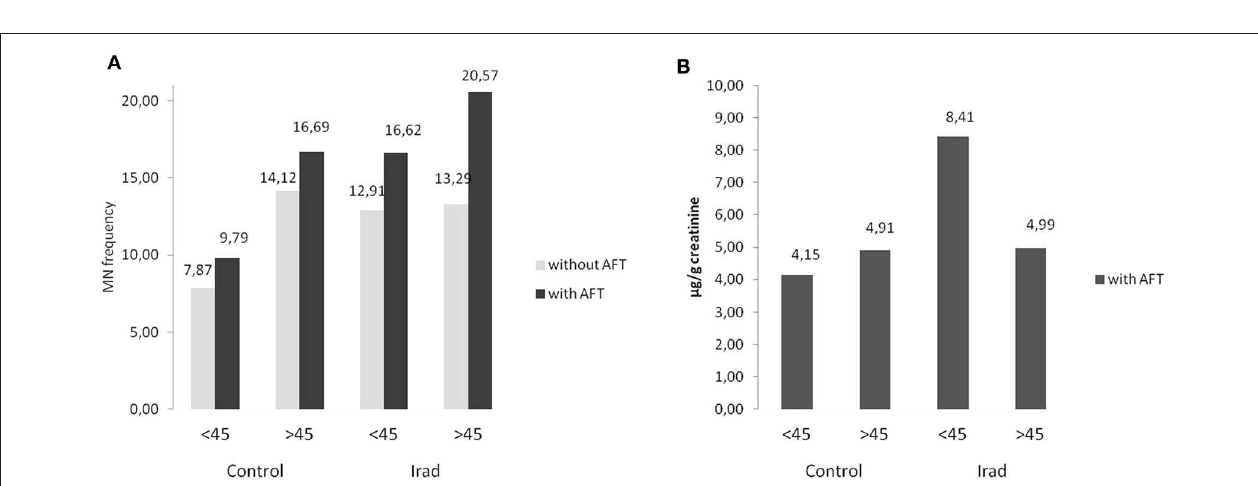
FIGURE 4 | Influence of participants’ age on micronucleus frequency (A) and 8-OHdG values (B) in hospital workers exposed to ionizing irradiation. MN, micronucleus frequency; 8-OHdG, 8-hydroxy-2 ′ -deoxyguanosine